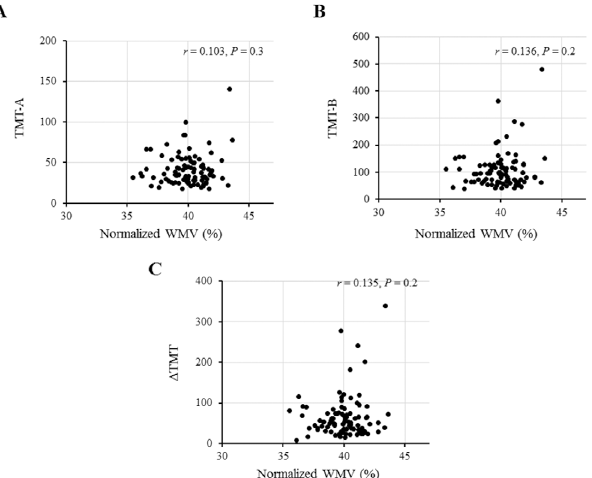
Fig 4. Correlations between normalized white matter volume (WMV) and the scores (times in seconds) of Trail Making Test (TMT). No correlations are found between normalized WMV and each score of TMT-A (A), TMT-B (B), and Δ TMT